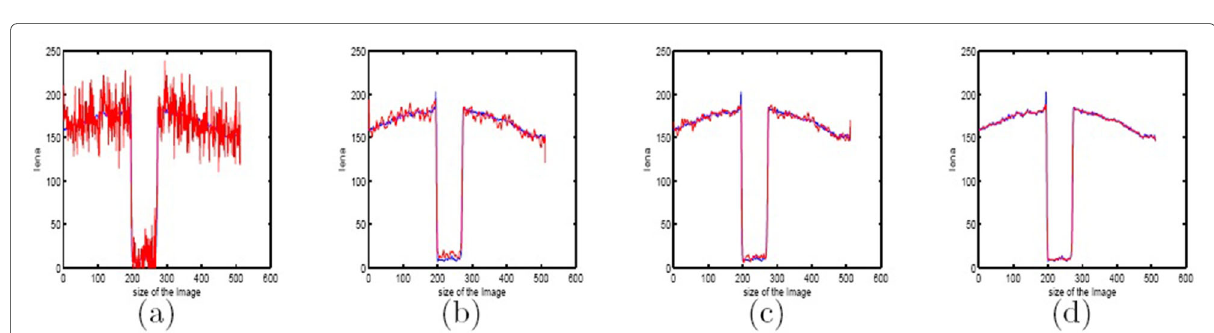
Fig. 12 The 99th line comparison of original image with noisy image, restored image by model M1, restored image by method M2, and restored image by method M3 of the “Lena”. a Original and noisy image lines; b original and restored by method M1 image lines; c original and restored by method M2 image lines; d original and restored by method M3 image lines. The blueline is the original image, and redline is the restored image